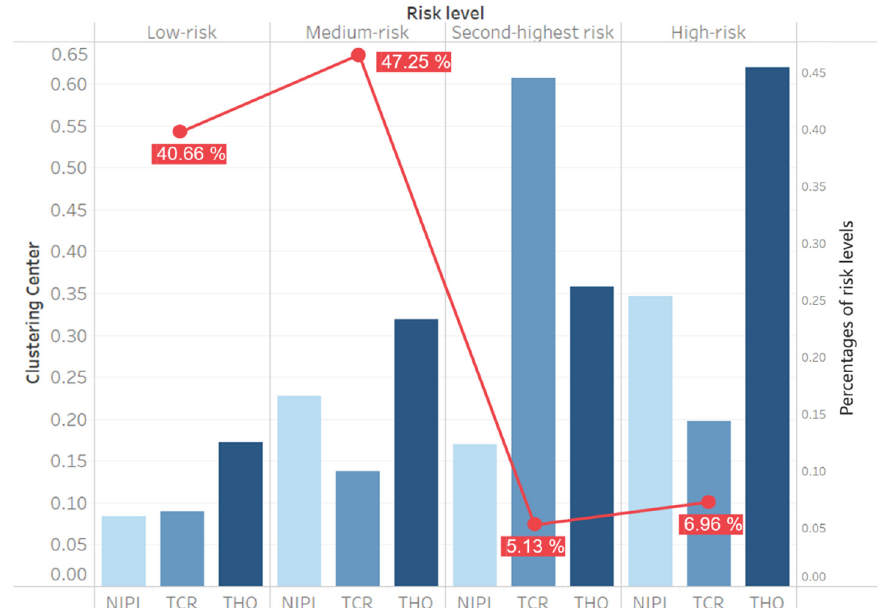
Figure 10. Distribution of different risk levels.